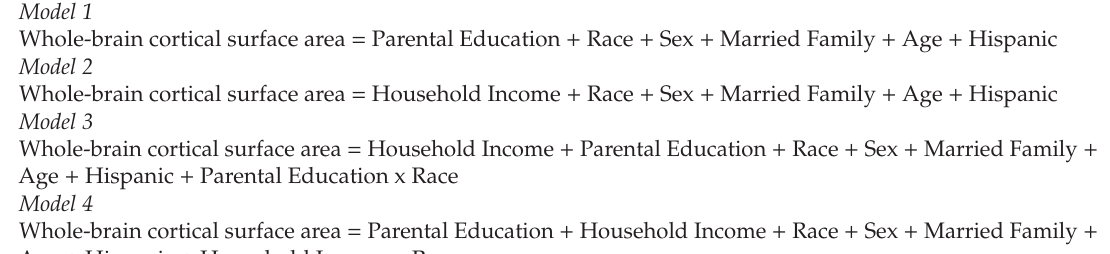
Table A2. Mixed-e ff ect regression model formulas to test the main e ff ects and interactions between parental education, household income, and race on the whole-brain cortical surface area of American children.